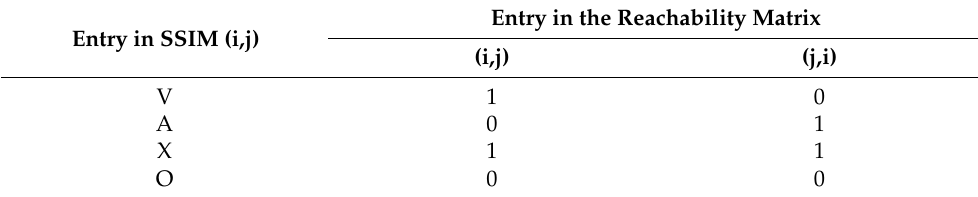
Table 3. The transforming rules for the